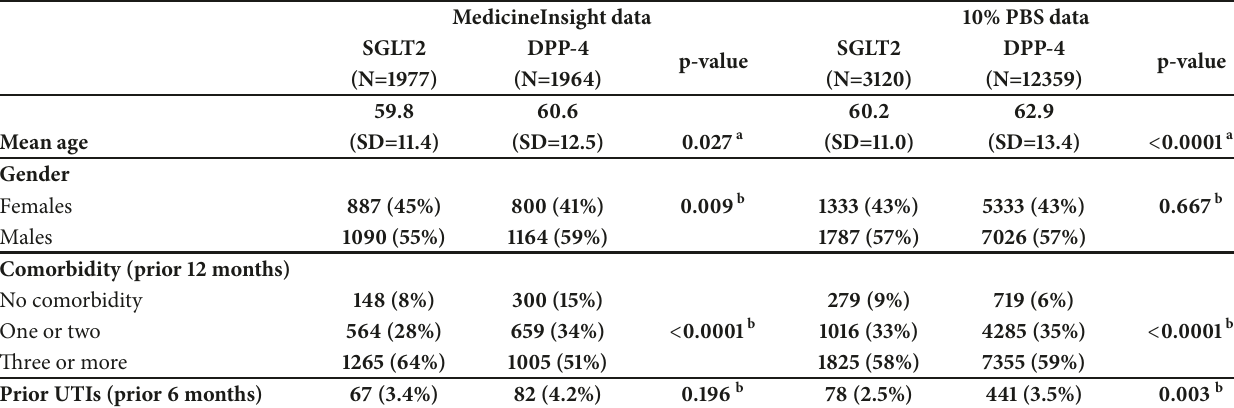
Table 1: Cohorts’